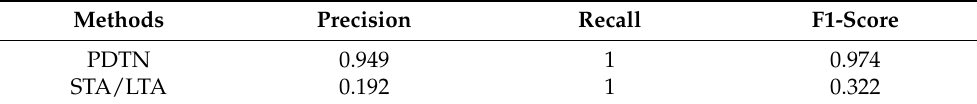
Table 5. The comparison of onset time picking between PDTN and